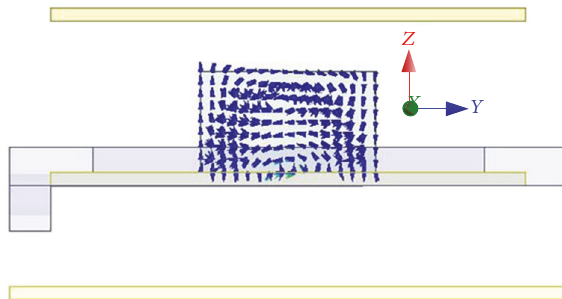
Figure 3: Simulated electric field distributions in the DR at 1.9GHz.